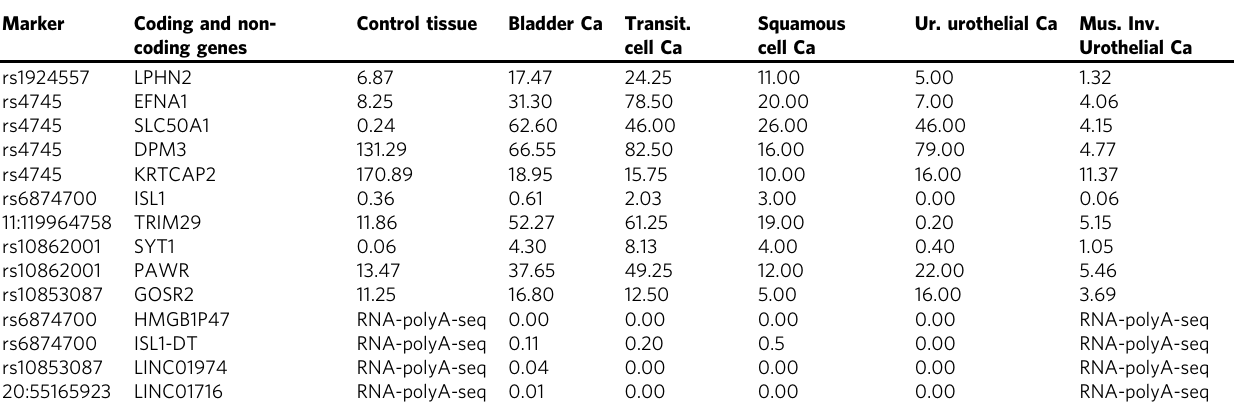
Table 4 Average TPM of coding and non-coding genes in the LD blocks of the most signi fi cant GWAS markers calculated for each bladder cancer cell line. Marker Coding and non- coding genes